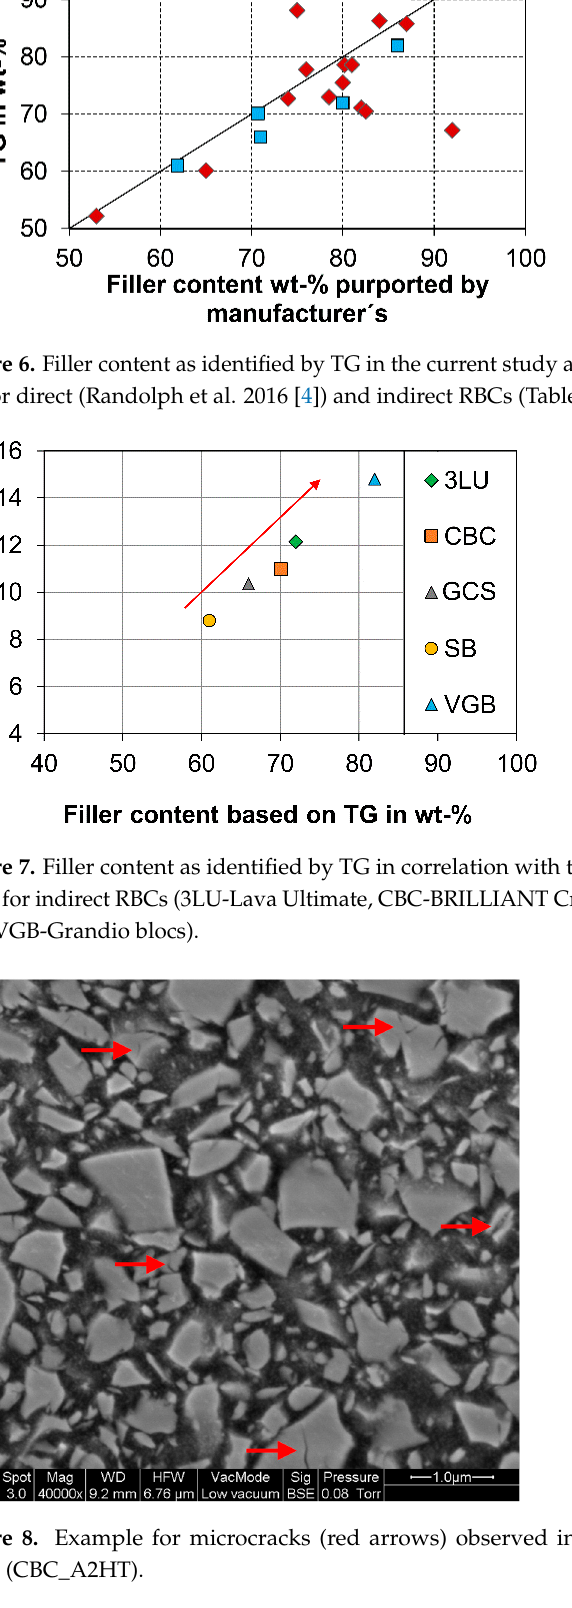
Figure 9. Example for porous edge area (yellow arrows) of filler particles in Lava Ultimate (3LU_A2LT). EDS and XRD analyses showed that the filler fraction of all CAD/CAM RBCs inves- tigated are Si-O-based X-ray amorphous phases which, depending on the manufacturer, often contain aluminium and barium (CBC, GCC, TC, and VGB) or zirconium (3LU and SB) as minor components. Barium and zirconium feature a high atomic mass, which is